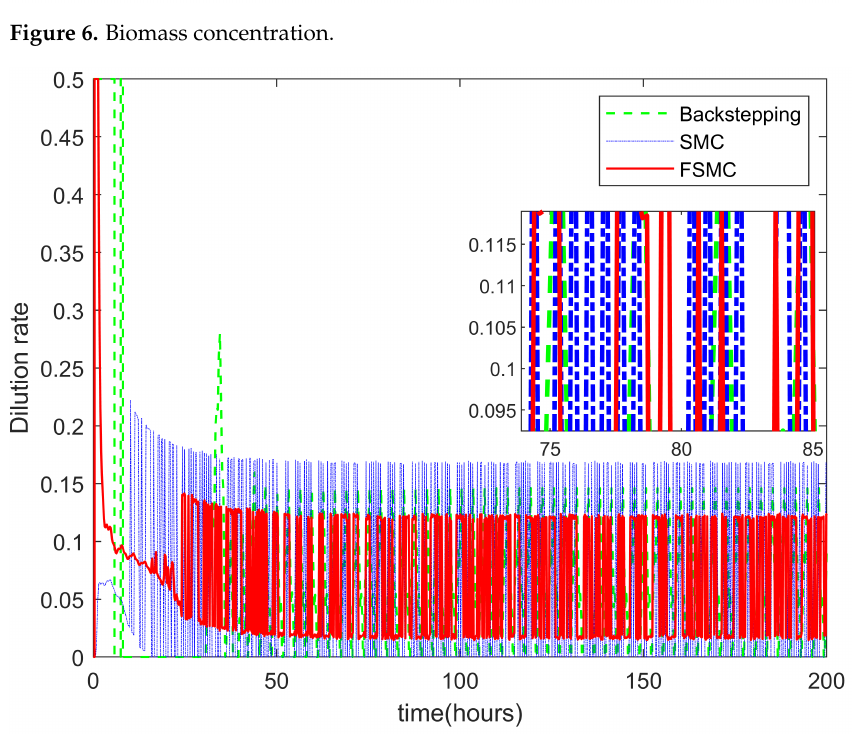
Figure 7. Dilution